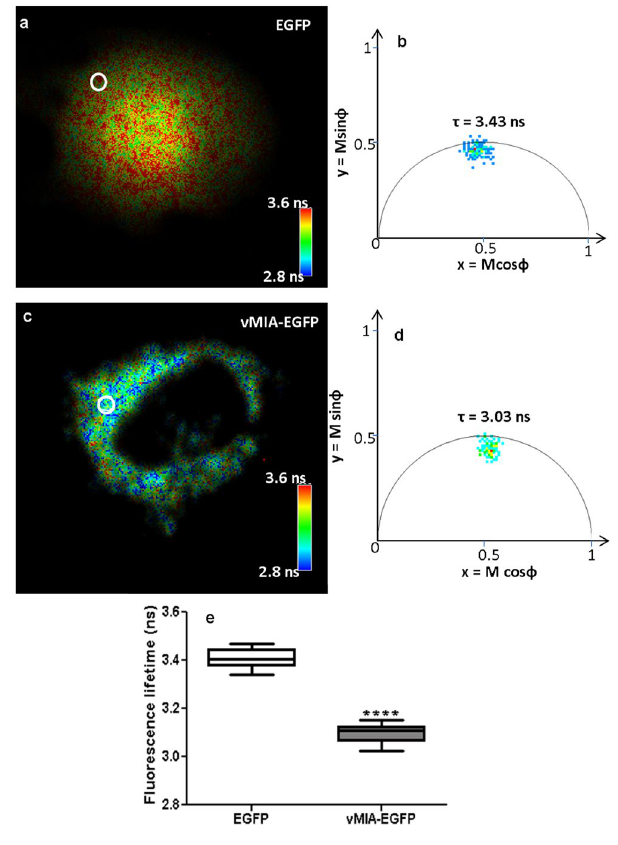
Figure 2. Use of fluorescence lifetime imaging to monitor vMIA homodimerization in WT MEFs. vMIA- EGFP was transiently expressed (as above) in WT MEFs, and live cells were imaged by using frequency domain lifetime microscopy. ( a ) Fluorescent lifetime image of a WT MEF expressing cytosolic EGFP. The pixels are pseudocolored based on their lifetime values as indicated by the heat map scale. ( b ) Fluorescence lifetime polar plot representing the frequency characteristics of each pixel in the ROI marked by the white circle in panel a. The colored squares represent a unique pixel lifetime and the red square marks the median lifetime value of the ROI ( c ) Fluorescent lifetime image of a WT MEF expressing vMIA-EGFP. The pixels are pseudocolored based on their lifetime as in panel b. ( d ) Polar plot presentation of the fluorescence lifetime of the ROI marked by white circle in panel c. The plot coordinates for ( b ) and ( d ) are x = M cos φ and y = M sin φ , where M is the modulation and φ is the phase delay. ( e ) The fluorescence lifetime comparison of cytosolic EGFP ( τ = 3.41 ± 0.01 ns, n = 140 ROIs from 14 cells) and vMIA-EGFP ( τ = 3.10 ± 0.01 ns, n = 130 ROIs from 13 cells) in WT MEFs. **** Represents p <